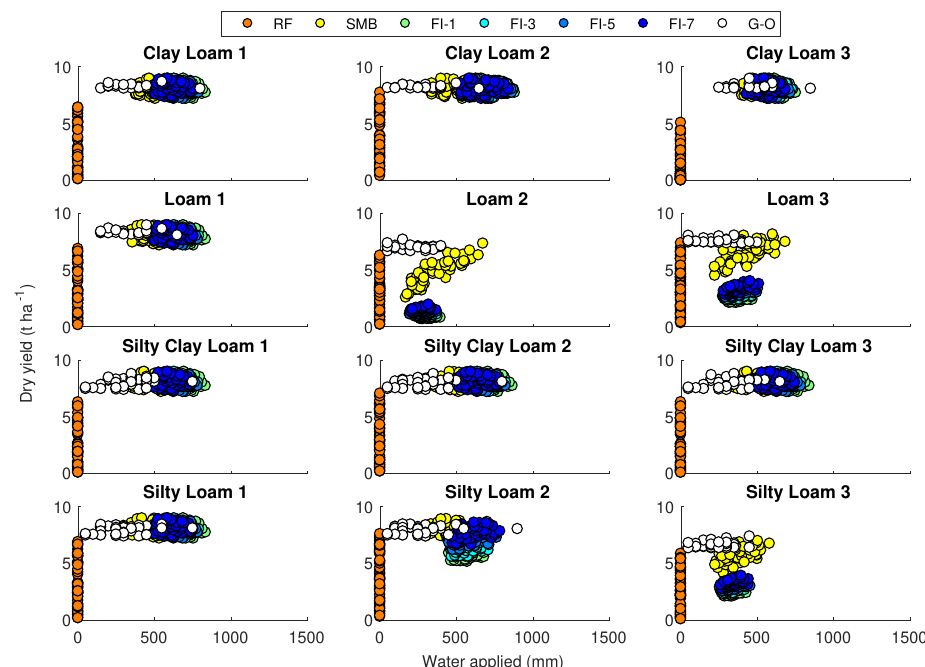
Figure 6. Dry yield as a function of water use for wheat for soils with low (1), medium (2), and high (3) bulk densities under different irrigation strategies: RF: Rainfed; SMB: Soil moisture-based; FI: Fixed interval every 1, 3, 5, and 7 days; and G-O: GET-OPTIS considering simulated values from 1965 to